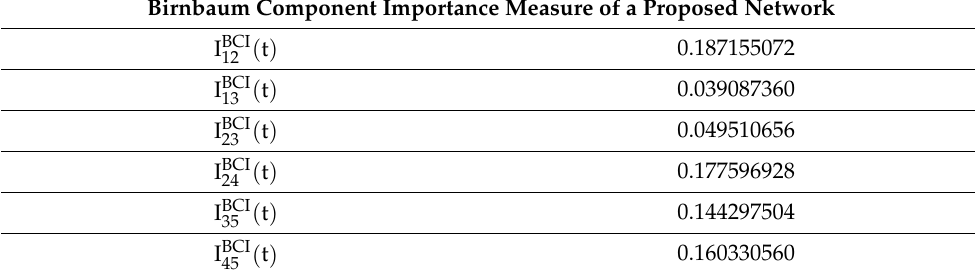
Table 4. Values of Birnbaum component importance